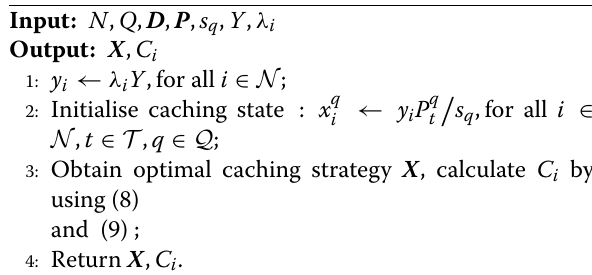
Algorithm 1 Edge caching strategy based on the content